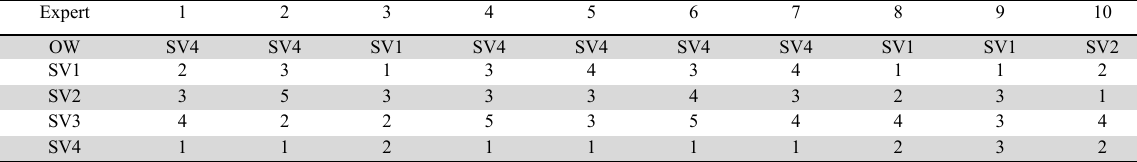
Strategic value preferences (Others to worst)